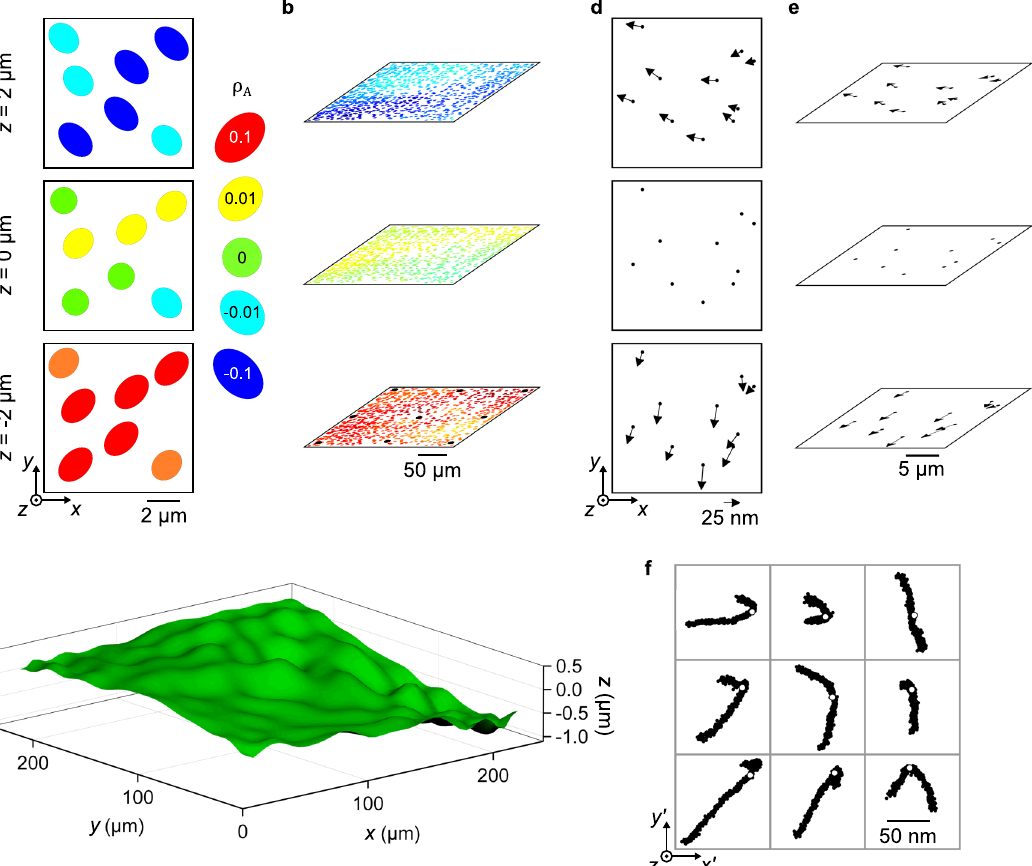
Fig. 4 Field dependence of image shape and apparent lateral position. a Schematic showing variation of image shape, with quanti fi cation by ρ A , in three dimensions. b Scatter plots in perspective showing the lateral positions of the calibration particles and their values of ρ A for the three representative values of z in ( a ). Black markers correspond to the particles in ( f ). c Surface plot showing a wide fi eld calibration function of Zernike polynomials modeling variation in z for a representative value of ρ A = 0. d – e Vector plots showing the apparent lateral motion of a subset of calibration particles for the three representative values of z in ( a ). f Grid of nine scatter plots showing the apparent lateral positions, through an axial range of 6 µ m, of representative calibration particles from representative locations across the full lateral fi eld. Black markers in the bottom plot of ( b ) show these representative locations. White data markers indicate the true lateral position of each particle, which we de fi ne as being at the z position of best focus, z f , for each